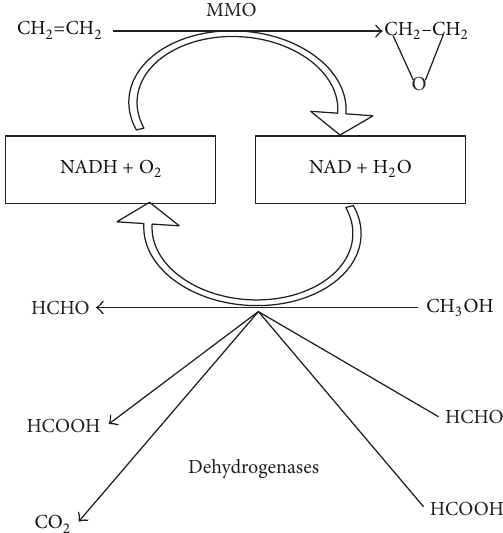
Figure 3: NADH regeneration scheme for the production of epoxyethane.